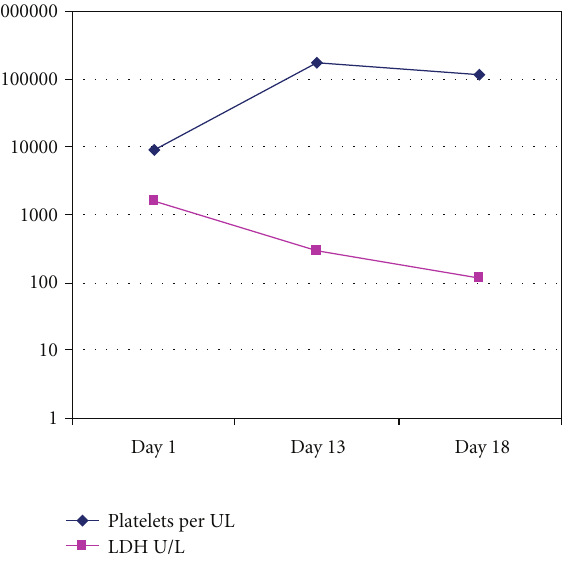
Figure 1: Platelets and LDH logarithmic trend in